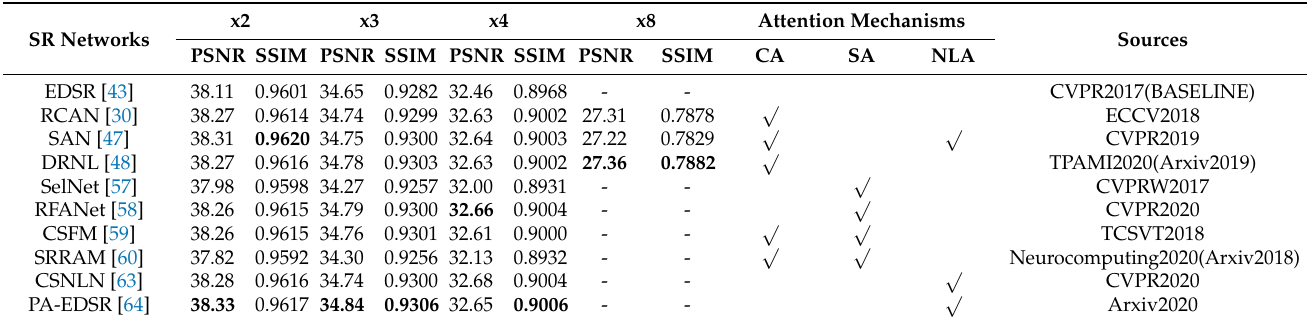
Table 1. The scores of different SR network on Set5 [68] and sources of all networks mentioned in the paper. The EDSR network is set to be the baseline without any attention mechanism. The best scores are in